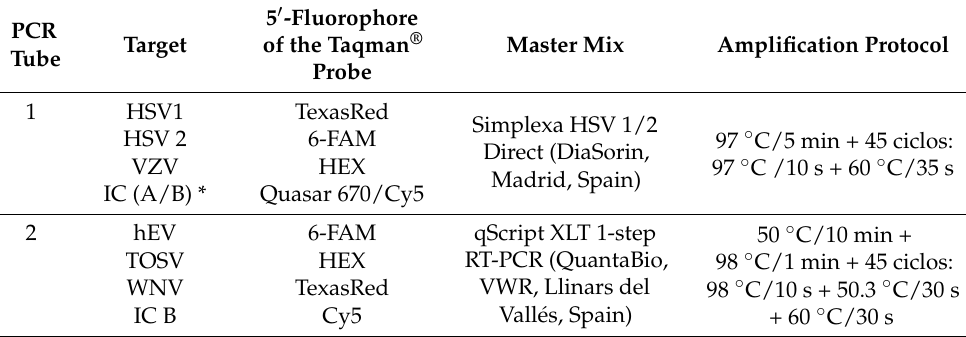
Table 2. Characteristics of the multiplex molecular panel validated in the BDMax system. PCR